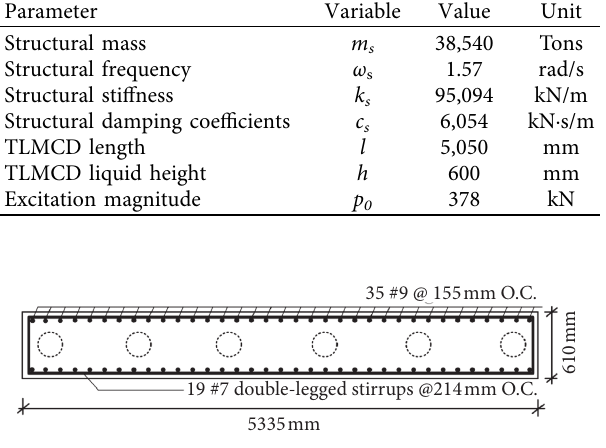
Figure 5: Cross-section view of the RC wall and embedded location of a single-layered 6-column TLMCD (columns in dashed line).